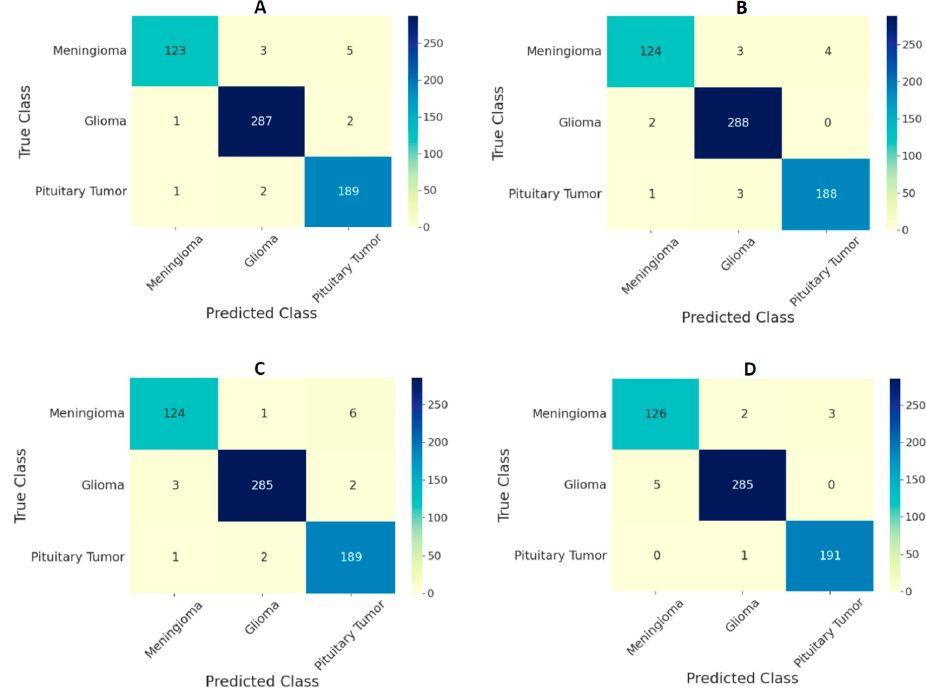
Figure 5. Confusion matrix for classification of three types of tumors on the test set using ViT models